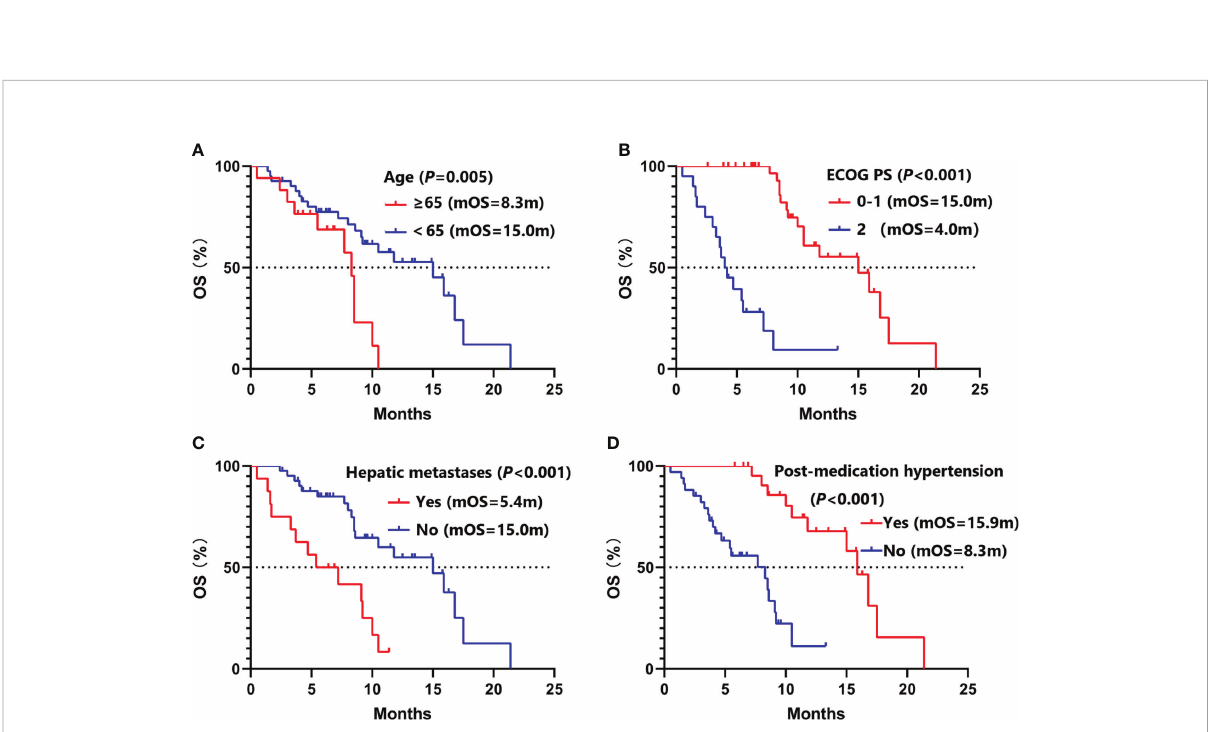
FIGURE 4 Kaplan – Meier curves of OS in multivariate Cox regression analysis. (A) strati fi ed by age; (B) strati fi ed by ECOG PS; (C) strati fi ed by hepatic metastases; (D) strati fi ed by post-medication hypertension. OS, overall survival; ECOG PS, Eastern Cooperative Oncology Group Performance